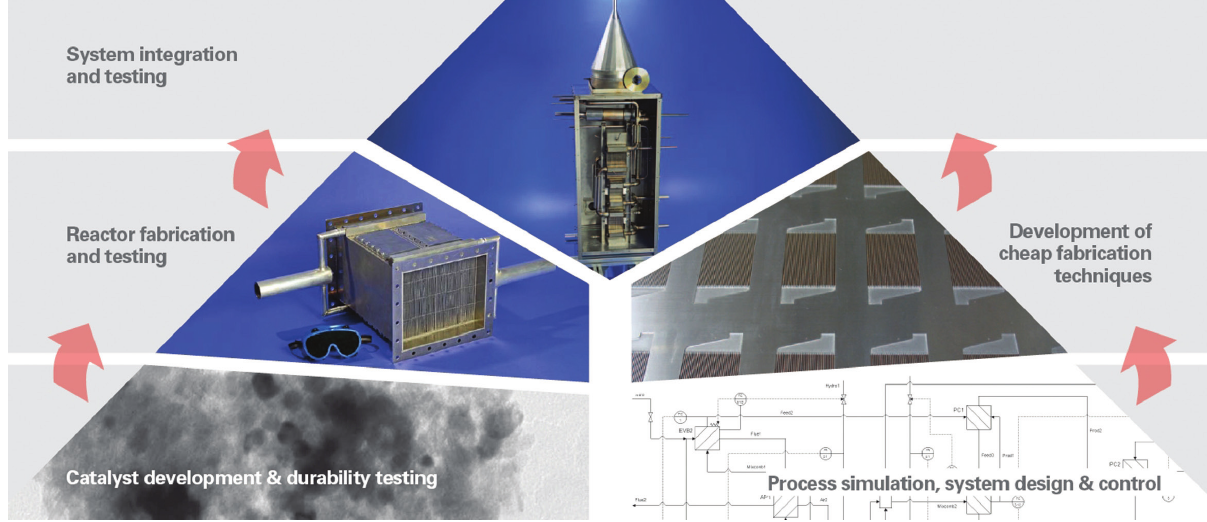
Figure 1 Complete portfolio of services